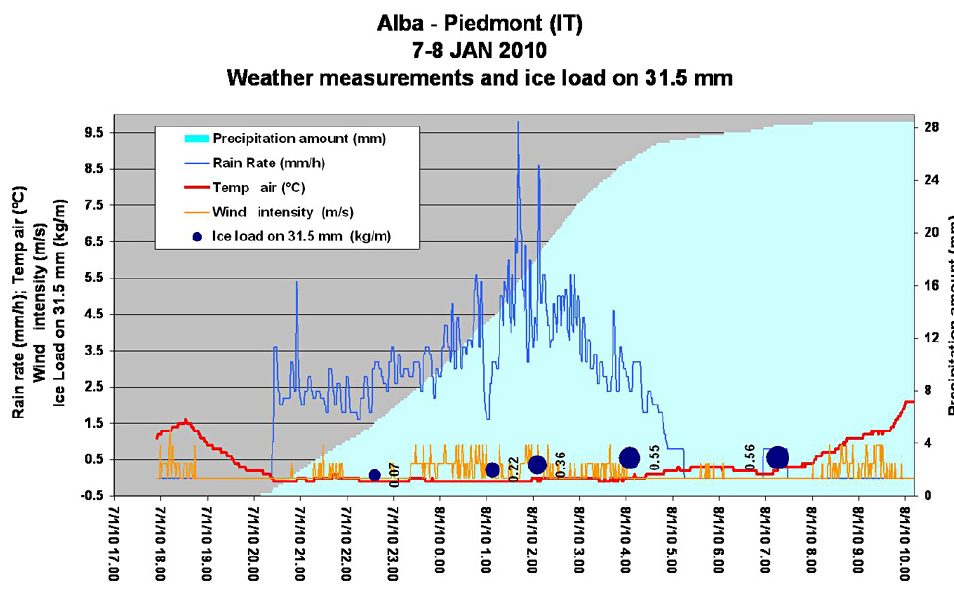
Fig. 9. Measurements collected during the experimental campaign of Alba (Piedmont; 7–8 January 2010).